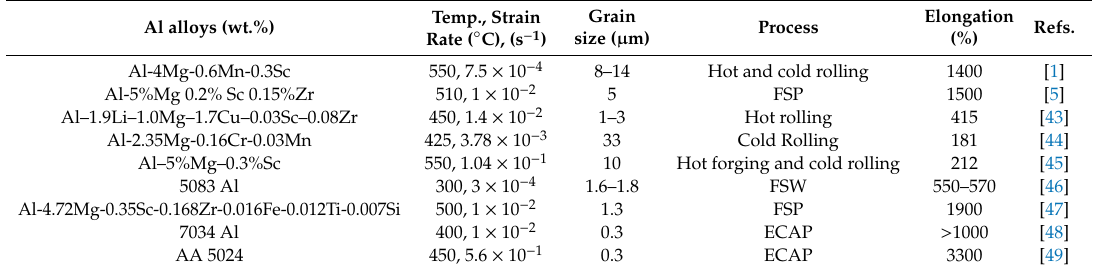
Table 1. Development of superplasticity in Al alloys in recent